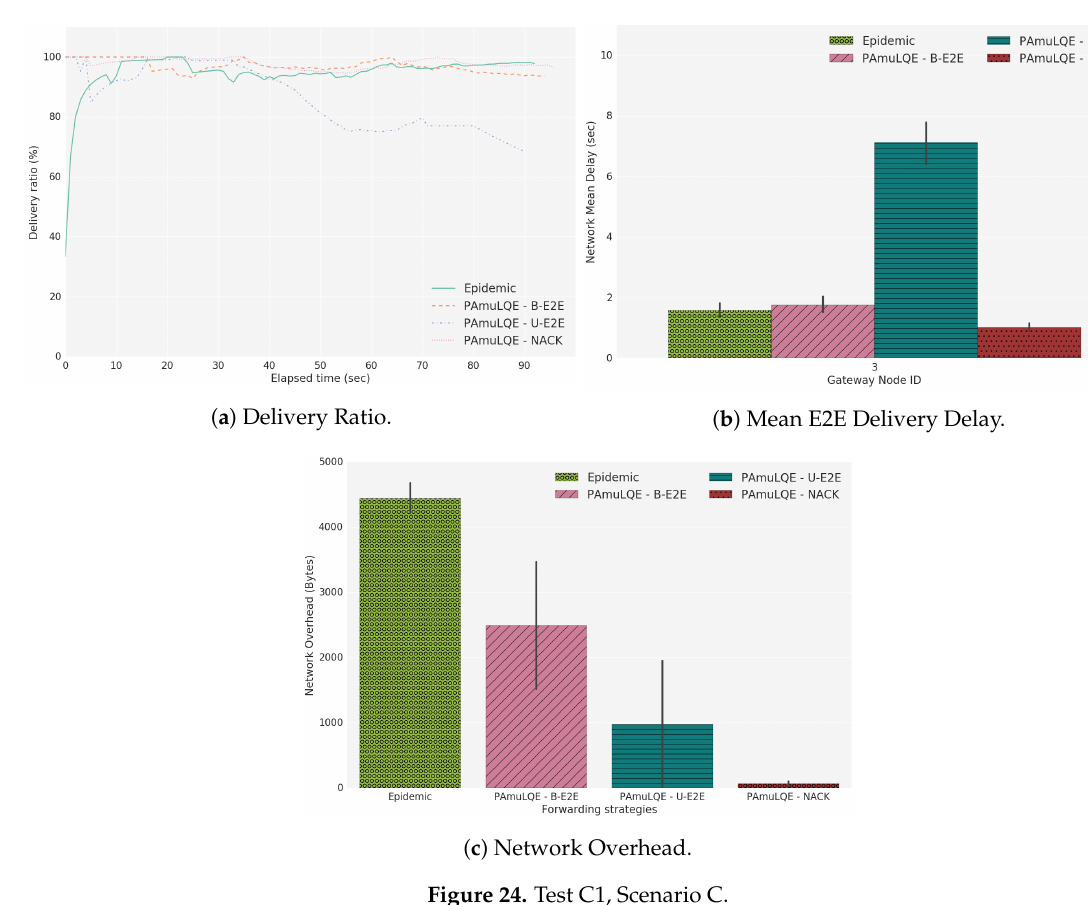
Figure 24. Test C1, Scenario